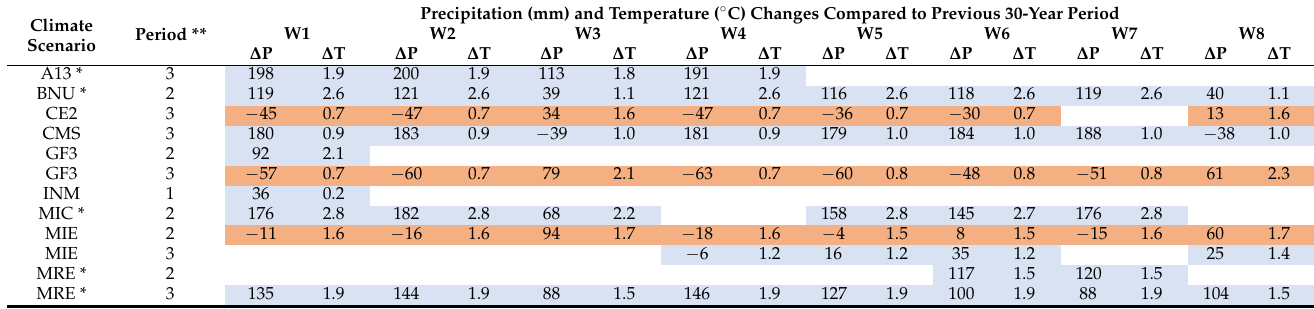
Table 5. Mean annual precipitation ( ∆ P) and temperature ( ∆ T) changes between 30-year periods associated with significant changes in groundwater recharge ( ∆ GWR) for the 12 climate scenarios and eight watersheds (W1 to W8) (cell color represents the direction of the ∆ GWR: orange for decrease and blue for increase, cells are empty when ∆ GWR was not